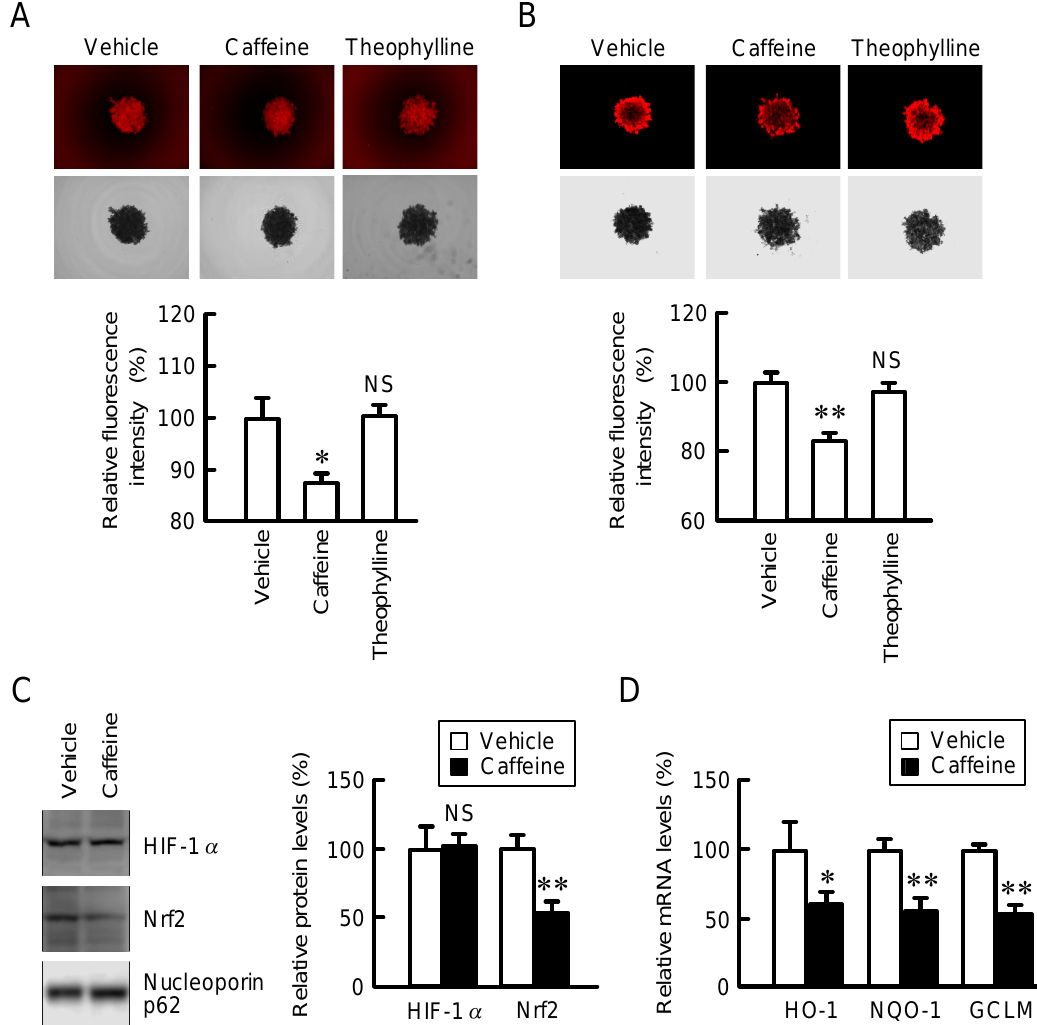
Figure 7. Effects of caffeine and theophylline on stress signals in spheroid cells. Spheroid cells were pre-incubated in the absence (vehicle) or presence of 200 µ M caffeine or theophylline for 24 h. ( A , B ) The cells were incubated with hypoxia marker LOX-1 ( A ) and ROS marker CellRox Deep Red ( B ). The upper and lower panels indicate fluorescence and bright field images, respectively. The fluorescence intensity is represented as a percentage relative to vehicle. ( C ) The protein expression of HIF-1 α , Nrf2, and nucleoporin p62 (a loading control) in spheroids was examined using Western blotting and represented as a percentage relative to vehicle. ( D ) The mRNA expression levels of HO-1, NQO-1, and GCLM in spheroids were examined using real-time PCR and represented as a percentage relative to vehicle. n = 3 – 7. ** p < 0.01, * p < 0.05, and NS p > 0.05 compared with vehicle.